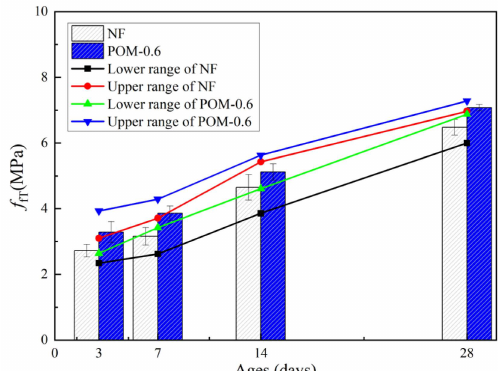
Figure 19. Test results of f fT for NF and POM0.6 SWSSC specimens with different concrete ages.